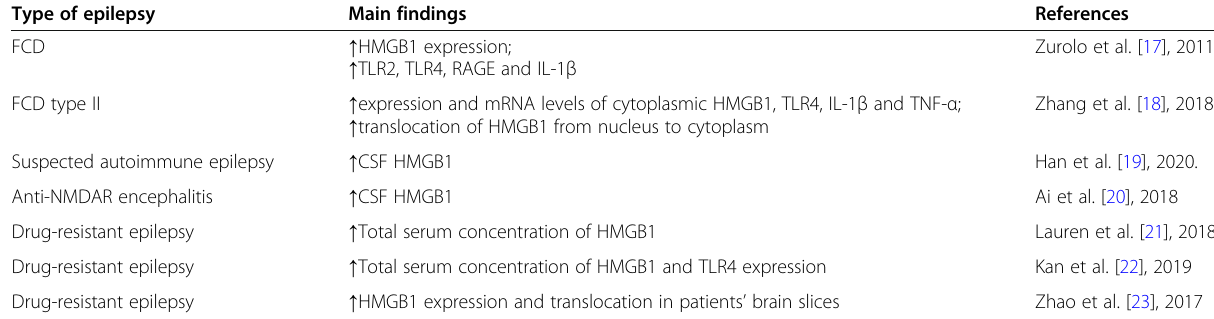
Table 1 HMGB1-related findings in patients with